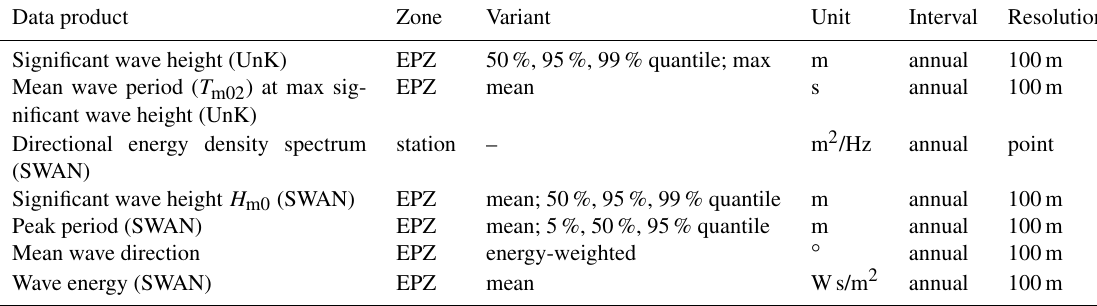
Table A2. Wave analysis products divided by the simulation software UnK and SWAN.